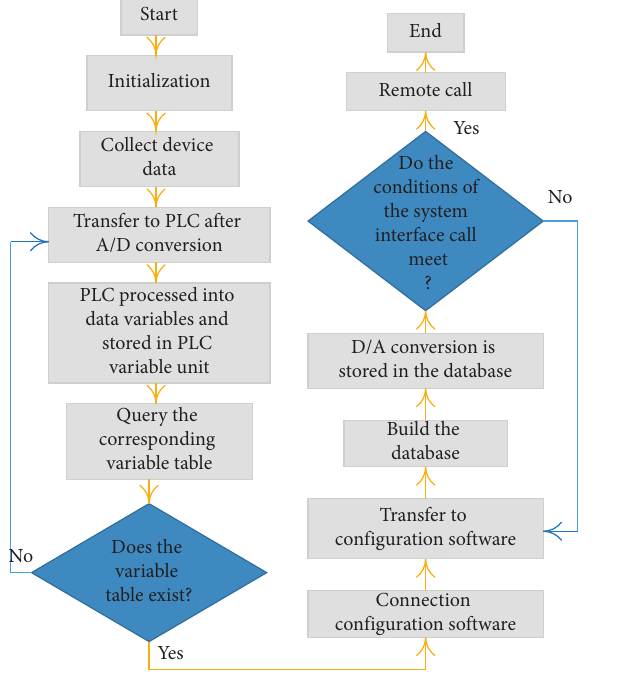
Figure 4: Storage of boiler operating status